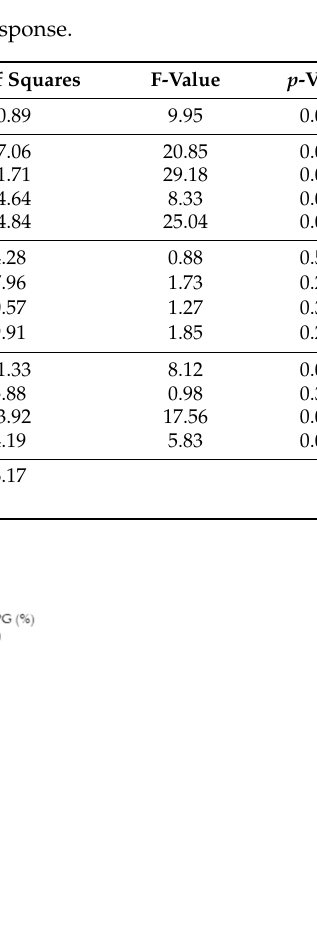
Lecithin were insignificant.